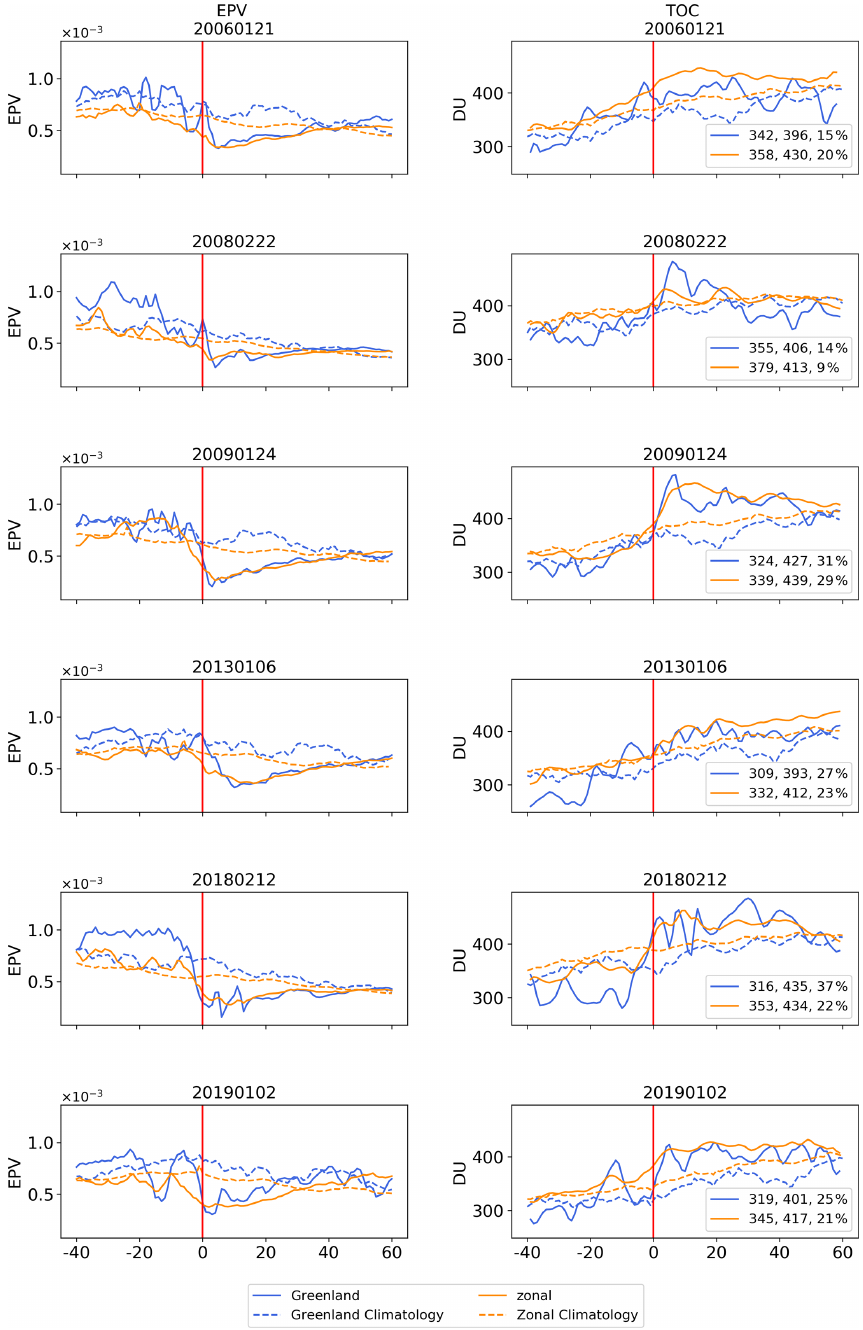
Figure 7. EPV at the potential temperature of 850k (first column) and TCO (second column) over the Arctic zonal mean 60–80 ◦ N (orange line) and Greenland sector (blue line) during the 40d before and 60d after each SSW (each row). Climatology of EPV and TCO for the zonal and Greenland sector is shown by dashed orange and blue lines, respectively. The average total column ozone (TCO) during the 40d before and 60d after and the percentage of change for each SSW are shown in the bottom corner of the second column.